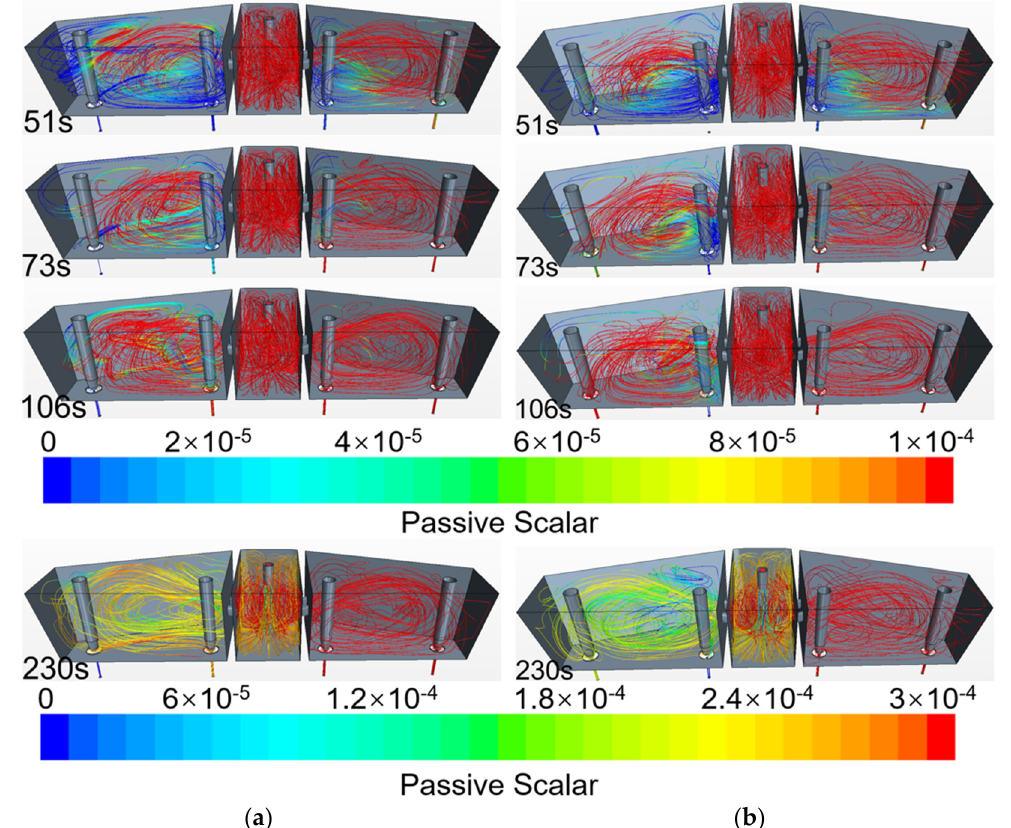
Figure 9. Streamline evolution of the double-weir tundish under single-strand blockage conditions, ( a ) strand 1 blockage, ( b ) strand 2 blockage. ( a ) strand 1 blockage, ( b ) strand 2